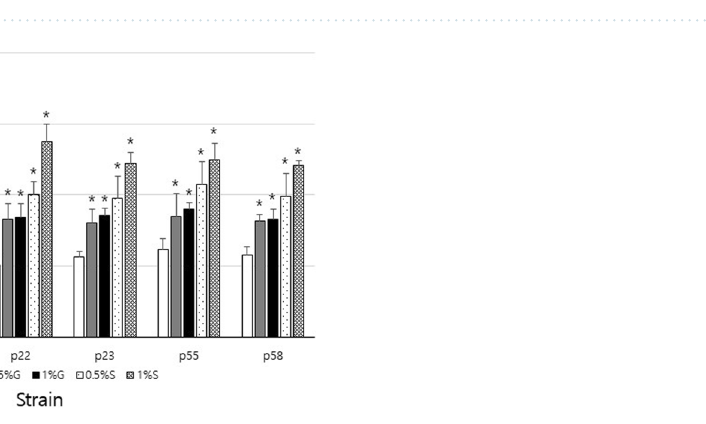
Figure 4. FE-SEM images of biofilms of E. faecalis ( a – e ) ATCC29212 and ( f – j ) OG1RF. E. faecalis biofilms were formed in 0% glucose + 0% sucrose (0%G + 0%S), 0.5% glucose (0.5%G), 1% glucose (1%G), 0.5% sucrose (0.5%S), or 1% sucrose (1%S) on the surface of hydroxyapatite (HA) disks. The images were examined with 30,000× magnification.